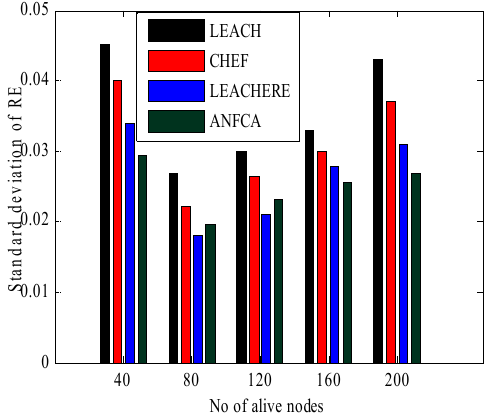
Figure 12. Standard deviation over alive nodes.